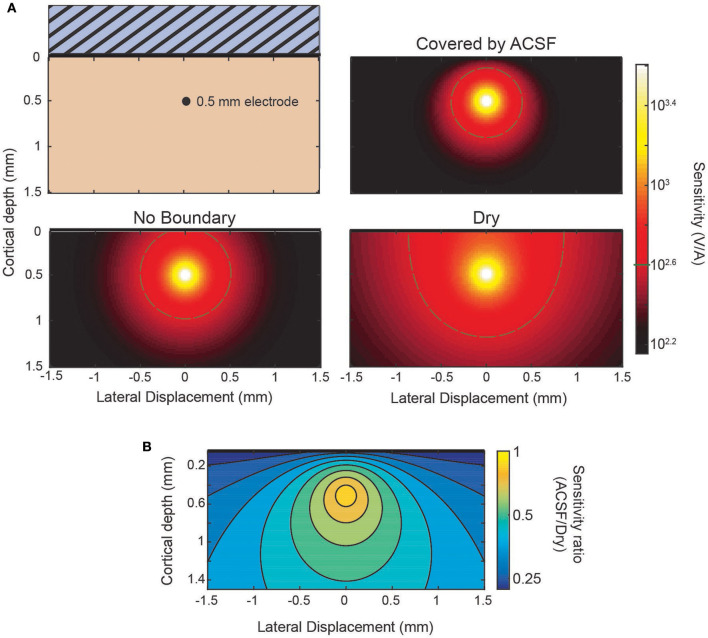
Sensitivity profiles of inserted electrode at 0.5 mm. (A) Lateral cross-section of the sensitivity of an electrode 0.5 mm deep. Comparison between the sensitivity without the presence of a boundary, with a conducting (ACSF) boundary, or an insulating (dry) boundary at the cortical surface. The 400 V/A threshold shown in gray. (B) The ratio of the ACSF and dry sensitivities from (A).